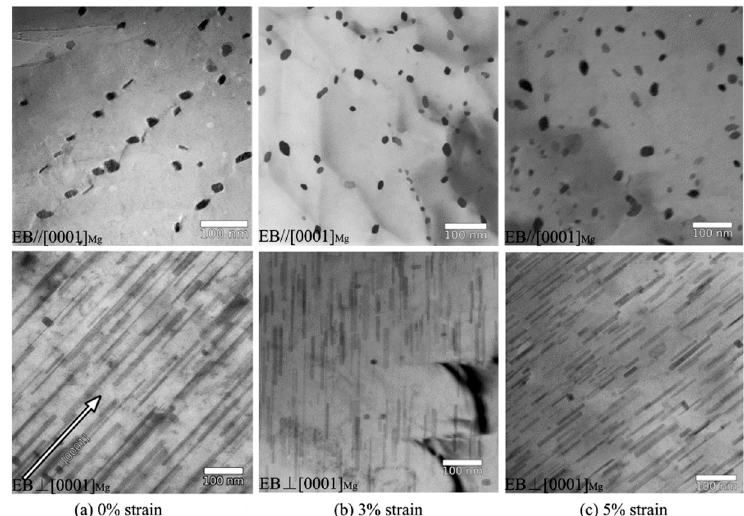
Figure 3. Transmission electron microscope (TEM) of β′ 1 precipitates in the optimum hardness conditions as a function of pre-tension deformation in an extruded binary Mg-3.0 at.% Zn alloy. ( a ) 0% strain, ( b ) 3% strain, and ( c ) 5% strain. EB is electron beam direction [55].